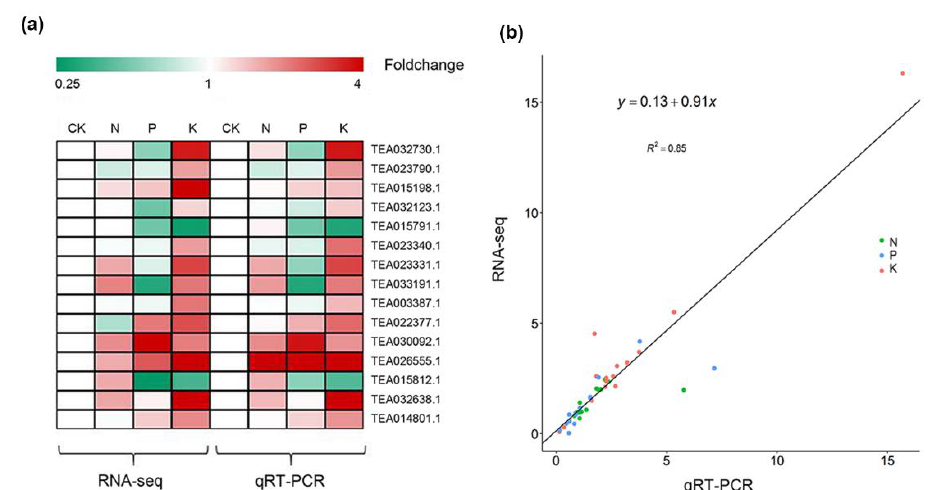
Figure 2. Quantitative real-time polymerase chain reaction (qRT-PCR) validation of 15 di ff erentially expressed genes (DEGs). ( a ) Heatmap of transcript levels of 15 DEGs and the corresponding expression of RNA-seq. ( b ) Comparison of the relative expression obtained from RNA-Seq data and qRT-PCR. The RNA-seq fold-change of the relative expression ( y -axis) has been plotted against the relative expression of qRT-PCR analysis ( x -axis).